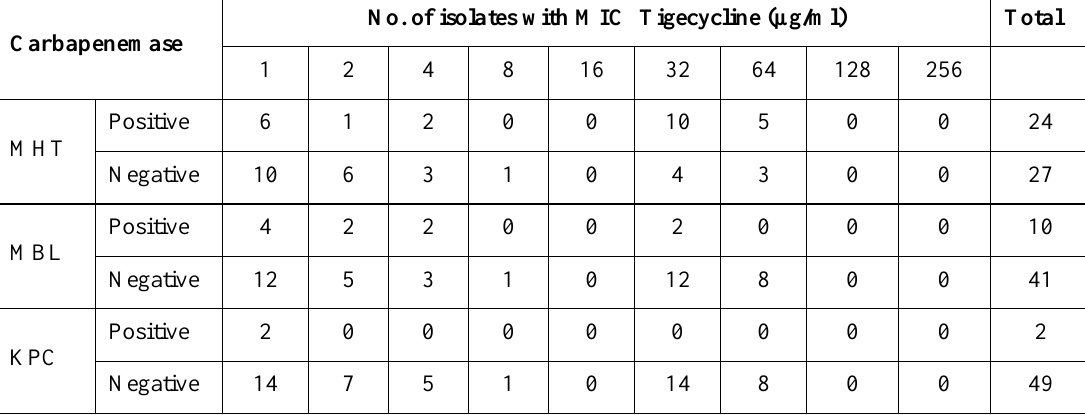
Table 4. Tigecycline MIC among carbapenemase